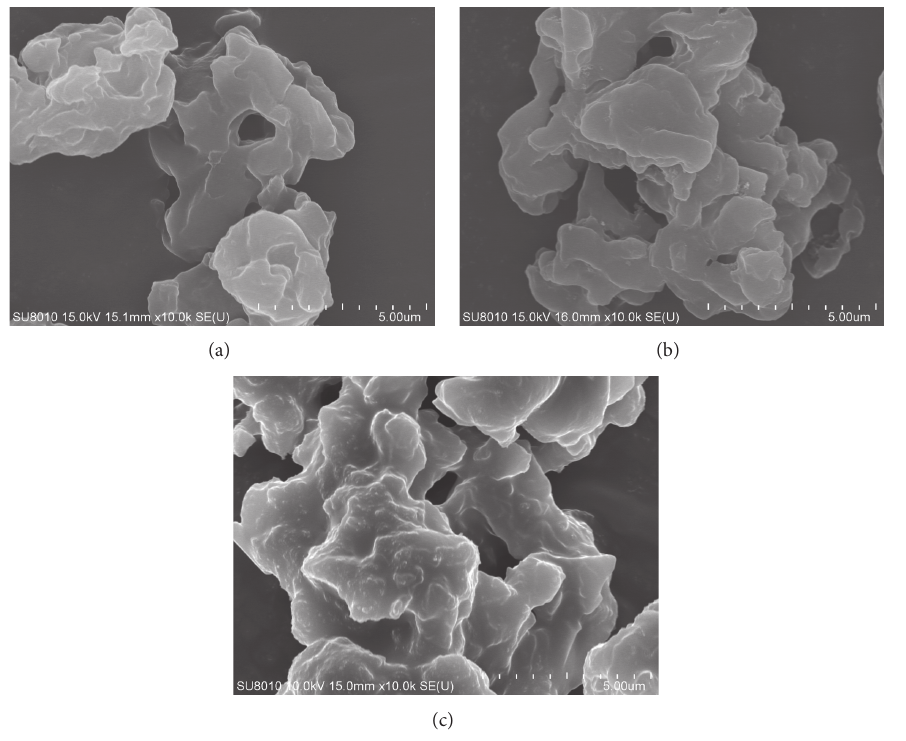
Figure 4: FESEM photographs of (a) PVPP, (b) PVPP-BS, and (c) [ PVPP-BS ] HSO 4 .